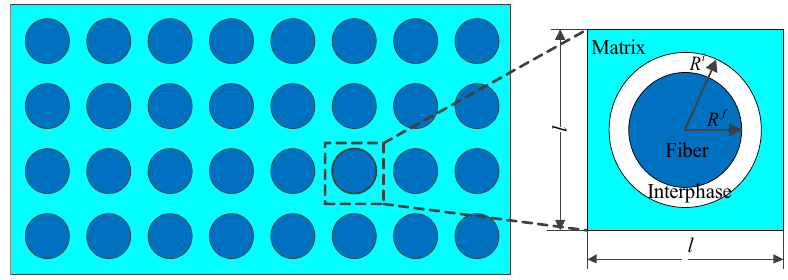
Figure 1: Three - phase RVE model of composites with interphase.